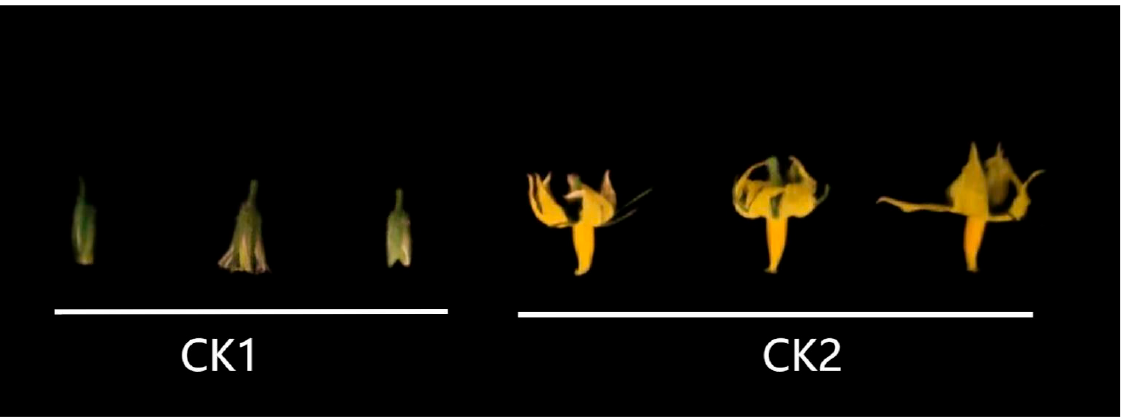
Figure 1. Flowers of AC at two stages. CK1: the bud stage; CK2: the full flowering stage. Table 1. Data quality of RNA-Seq.